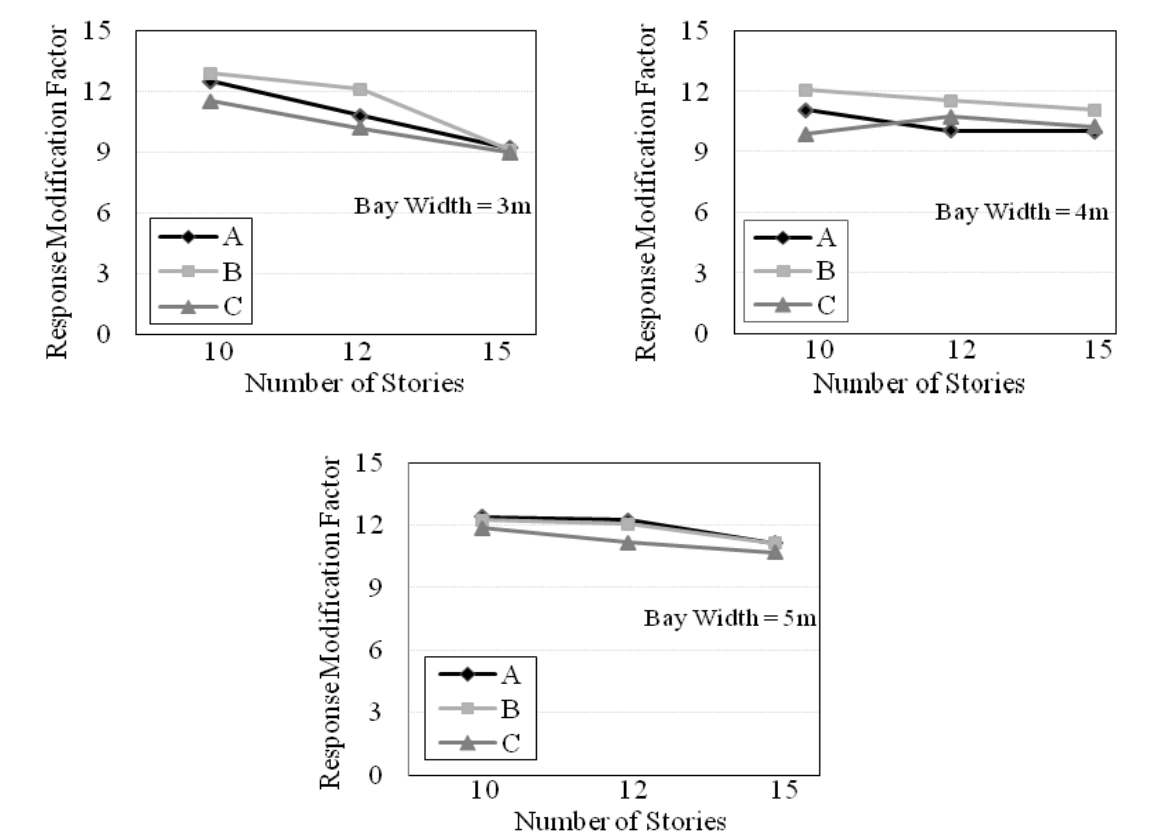
Fig. 9. Variation of response modification factor for different number of